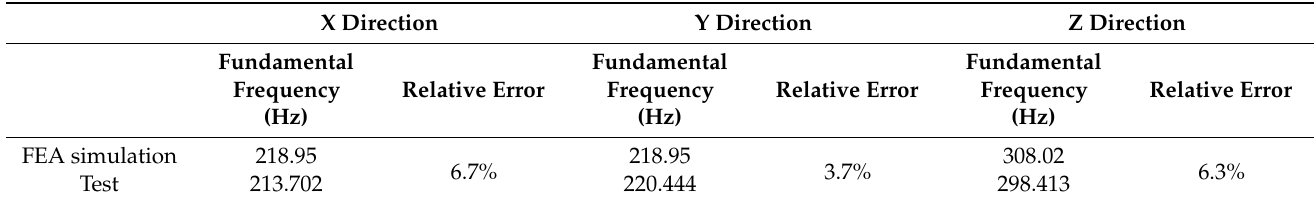
Table 2. Comparative analysis of simulation results and test